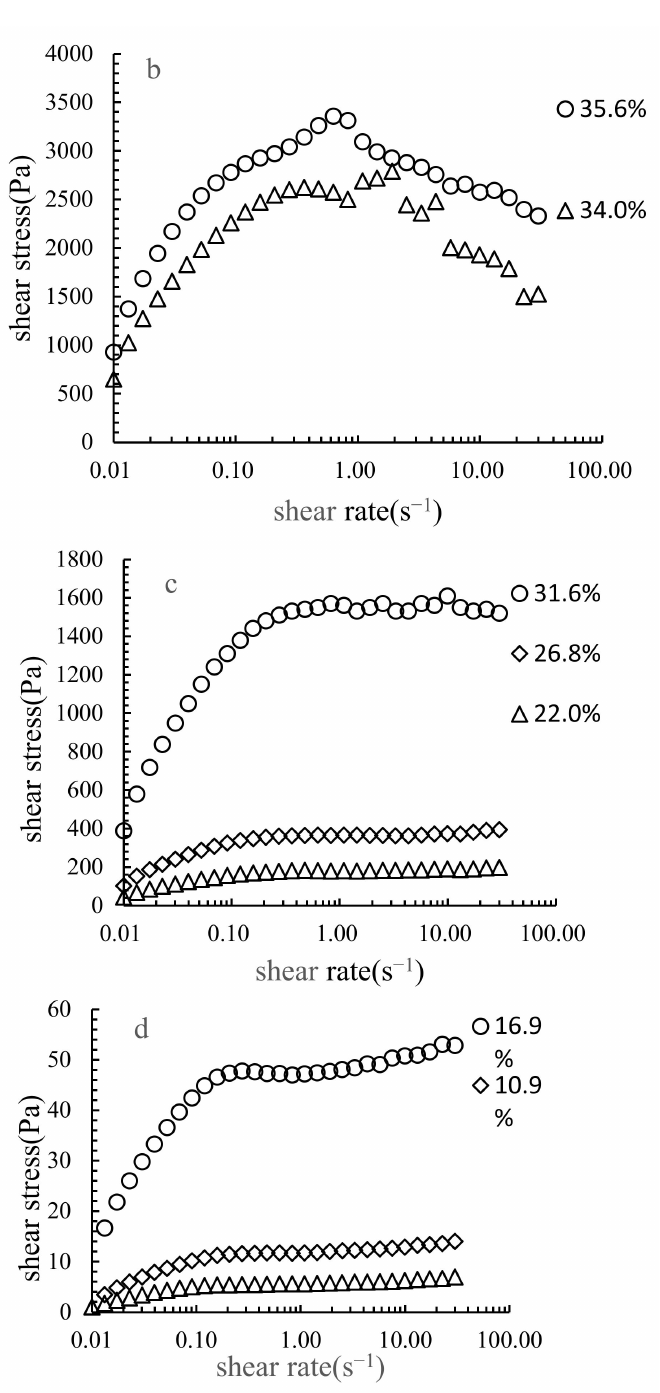
Figure 2. The shear stress vs. shear rate. The solid volume concentrations were 42.0%, 39.4% ( a ), 35.6%, 34% ( b ), 31.6%, 26.8%, 22.0% ( c ), 16.9%, 10.9% and 8.5% ( d ),